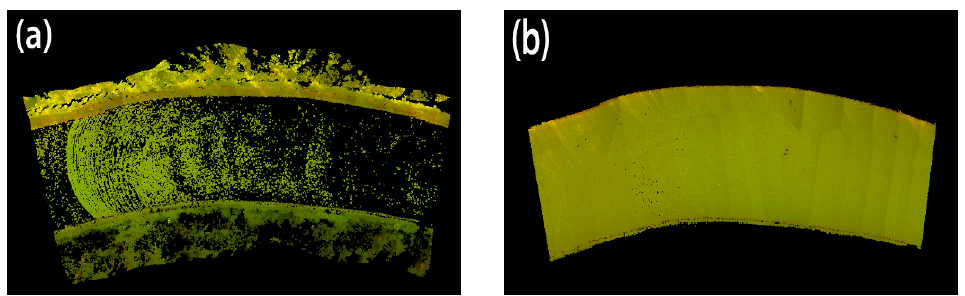
Figure 27. The ski-track was extracted from the Figure 23b: ( a ) is non-ski-track points; ( b ) is ski-track points.